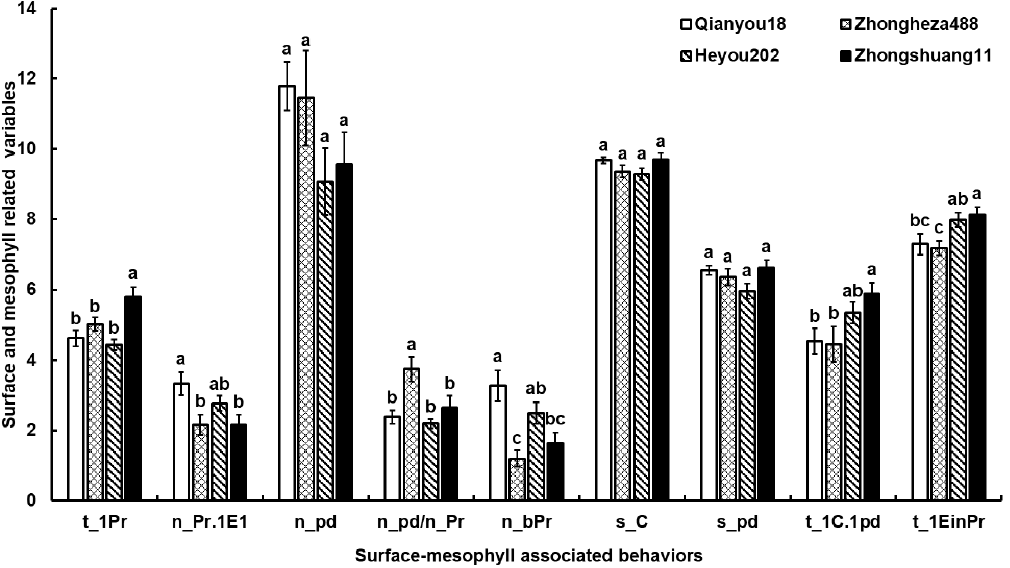
Figure 3. The electropenetrography (EPG) variables of the B. brassicae stylet pathway before reaching the phloem tissue of the host plants. Bars represent stand error (SE). The data were compared using the analysis of variance (ANOVA) followed by the unrestricted least significant differences (LSD) after the square-root transformation for frequency variables and natural log transformation for time variables. The level for significance was set to P < 0.05. Different lowercase letters on the columns indicated the significant differences among the four cultivars. 200